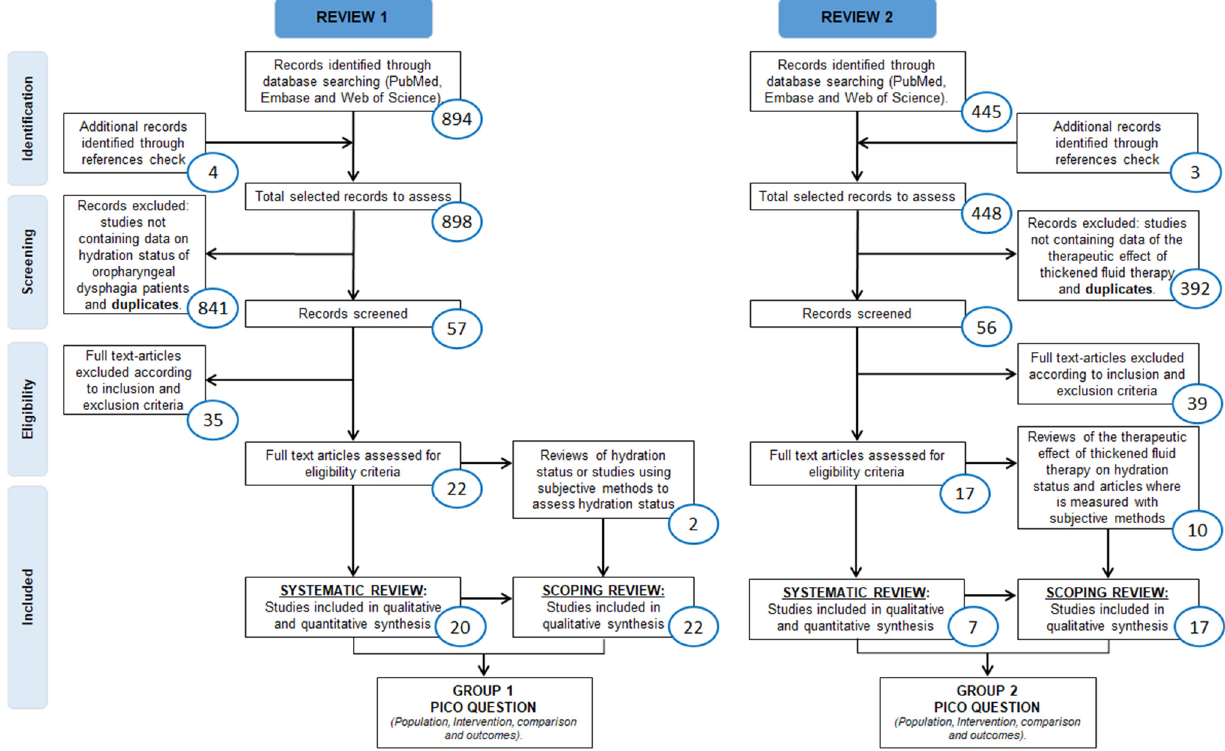
Figure 2. R1 and R2 flowcharts following the PRISMA guidelines including a systematic review and a scoping review for each one.